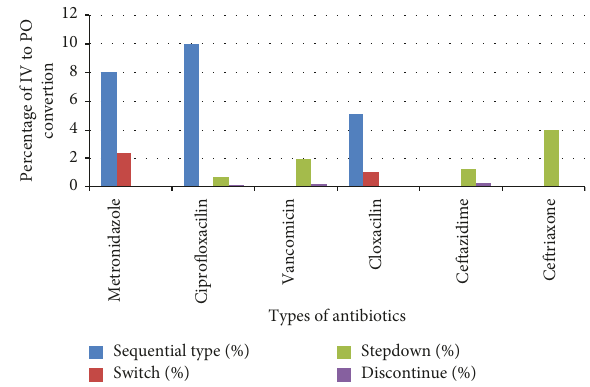
Figure 3: Types of IV to PO conversion practice at the University of Gondar Compressive Specialized Hospital from October 3 to November 14, 2021 ( n �